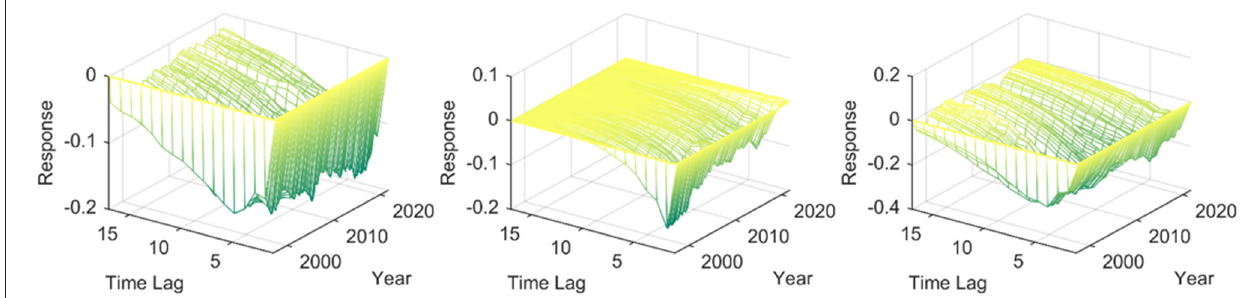
FIGURE 3 | Three-dimensional impulse responses of price-based monetary policy acting on mainland China. The three sub graphs represent the impulse responses of the primary, secondary, and tertiary industries from left to right, respectively. One period in the figure denotes one